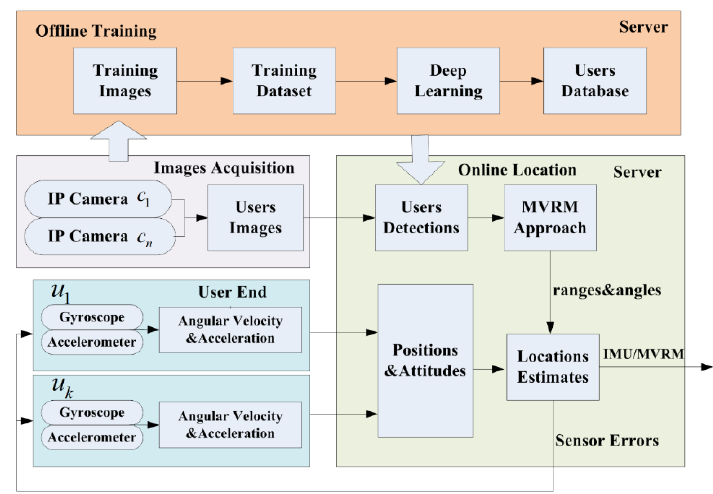
Figure 1. The concept of the proposed inertial measurement unit (IMU)/monocular vision relatively measuring (MVRM) integrated system.